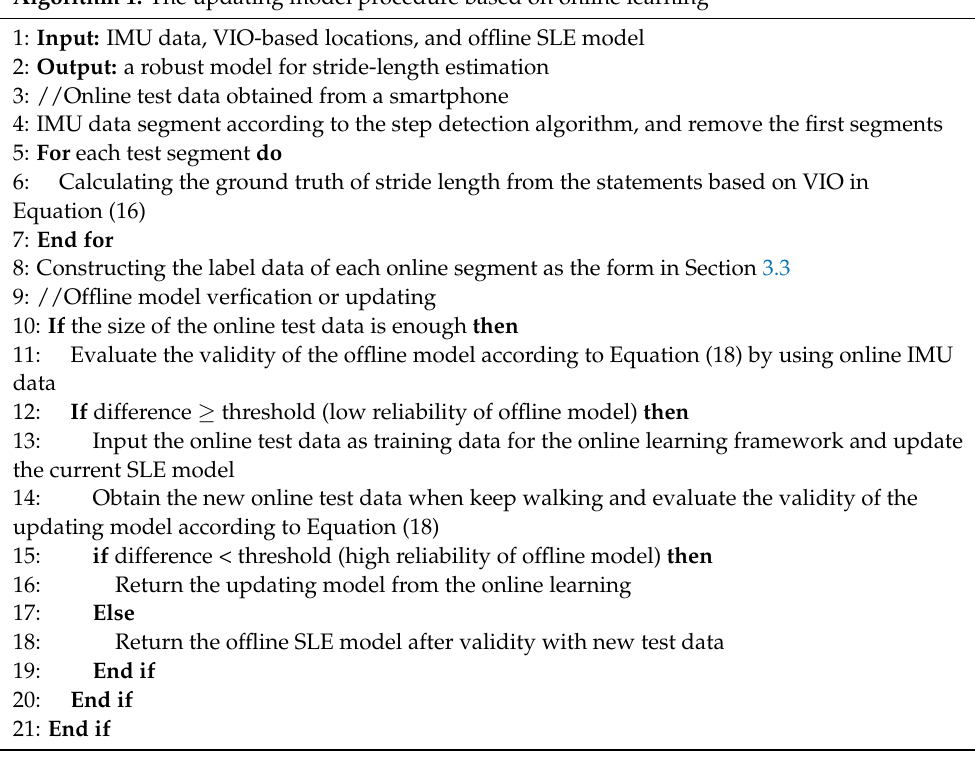
Algorithm 1: The updating model procedure based on online